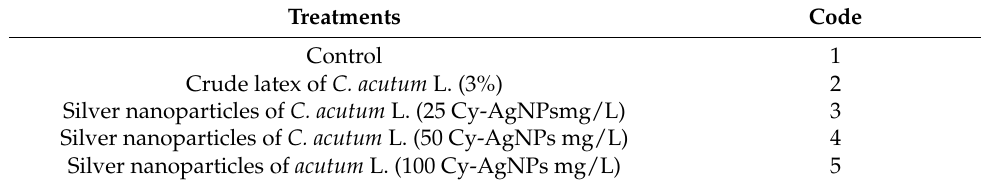
Table 6. List of extracts concentrations and their codes.